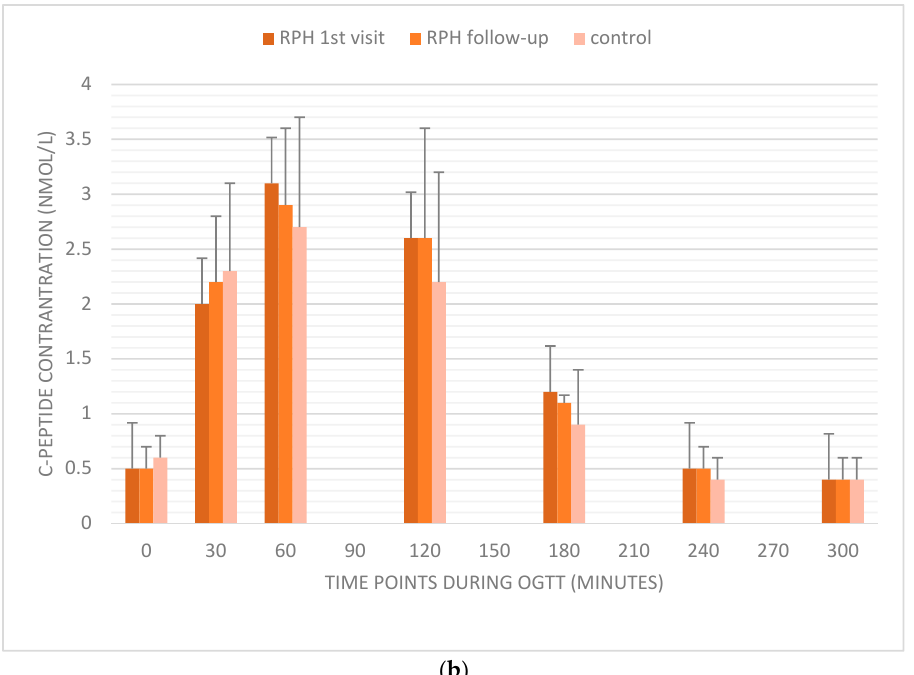
Figure 1. ( a ). Comparison of blood glucose concentration in subjects with RPH at baseline and follow-up vs. the healthy control group, showing no difference in any time point during 5-h OGTT. ( b ). Comparison of C-peptide concentration in subjects with RPH at baseline and follow-up vs. the healthy control group, showing no difference in any time point during 5-h OGTT. Legend: RPH: reactive postprandial hypoglycemia, OGTT: oral glucose tolerance test.